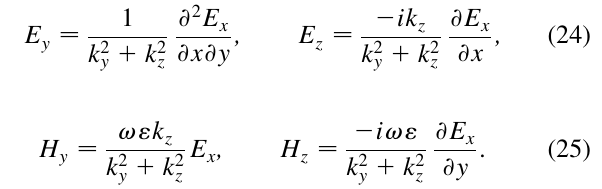
FIG. 6. (Color) Computational demonstration of Eqs. (17) and (cid:1) x; y (cid:2) and (b) dependence of I (18). (a) Dependence of I EE on x and y on the cross section of the two-zone structure given in (cid:1) x; y (cid:2) behaves as a (cid:2) function, while Fig. 4. It is seen that I EE (cid:1) x; y (cid:2) fluctuates around zero within 0 : 03 mm (cid:5) 2 I EH where m and n (cid:14) 1 for LSM modes, and m (cid:14) 1 and n (cid:14) 0